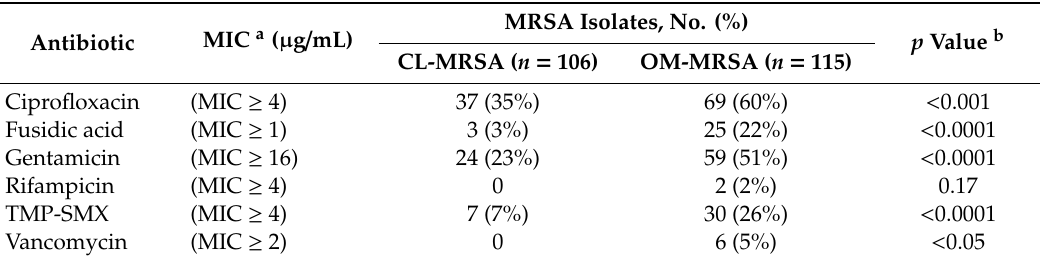
Table 2. Antibiotic resistance profiles of the isolated CL-MRSA and OM-MRSA strains.